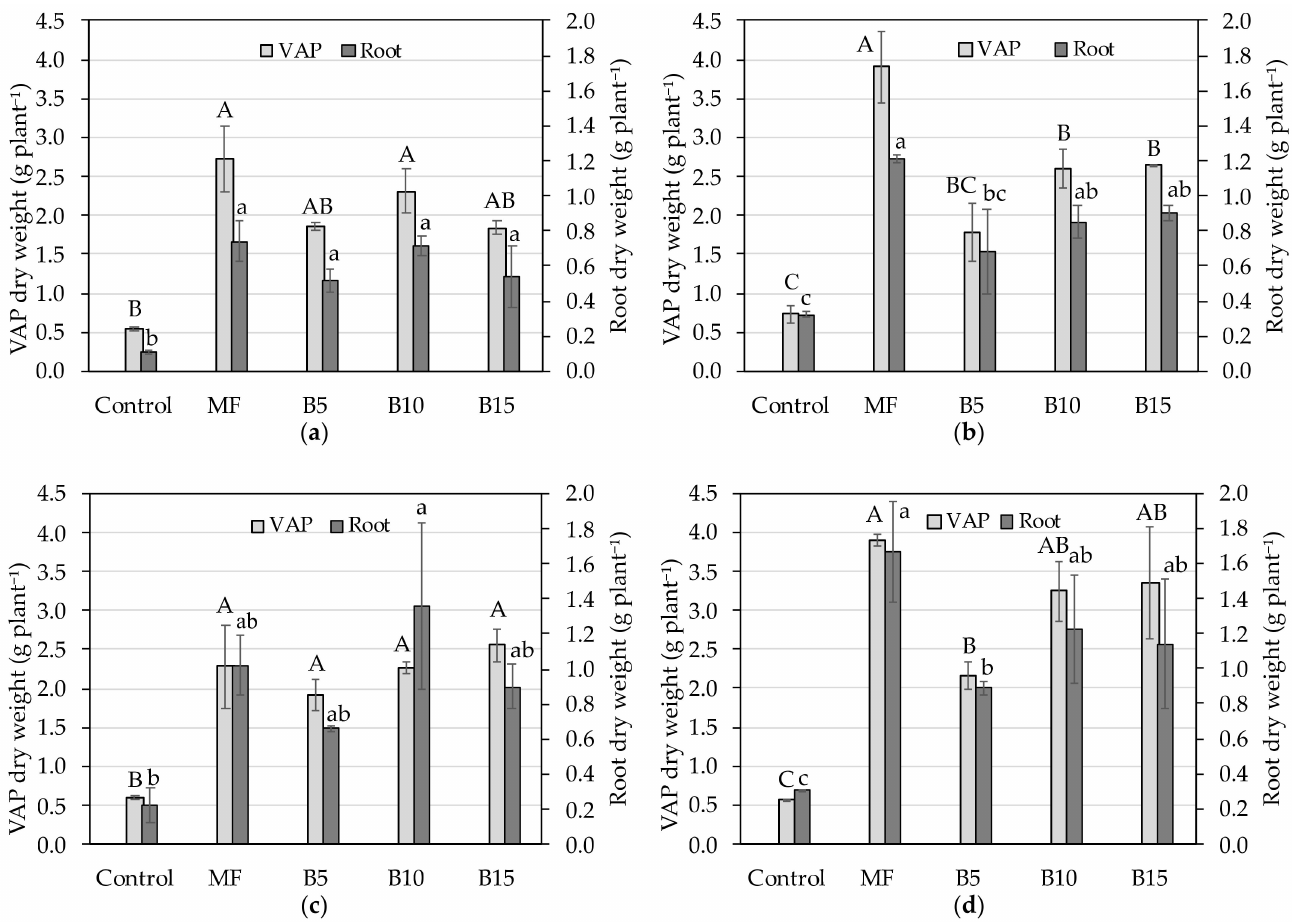
Figure 4. Biomass (DW g plant − 1 ) of VAP and roots of winter cereals, as affected by fertilizer treatments: ( a ) barley; ( b ) common wheat; ( c ) durum wheat; and ( d ) oat. Bars with different letters are significantly different according to Tukey’s test ( p > 0.95); uppercase letters refer to VAP and lowercase to roots. Error bars represent standard